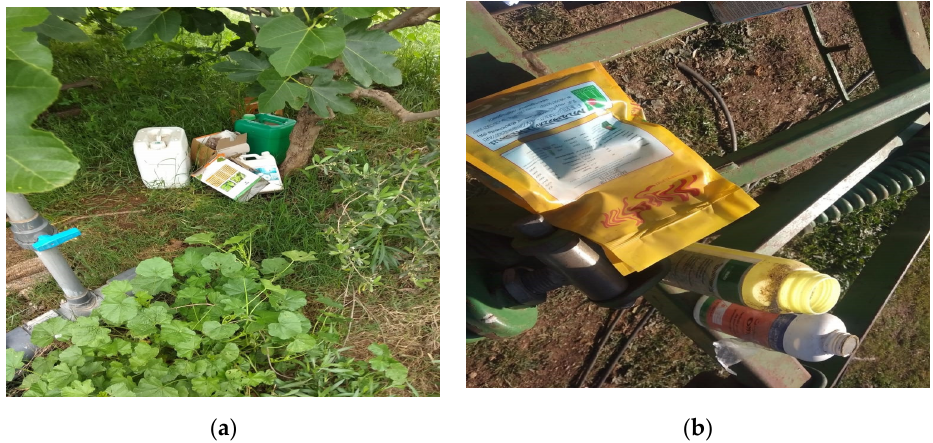
Figure 2. Elimination of empty pesticide packaging near a well ( a ) and at the edge of fields ( b ).